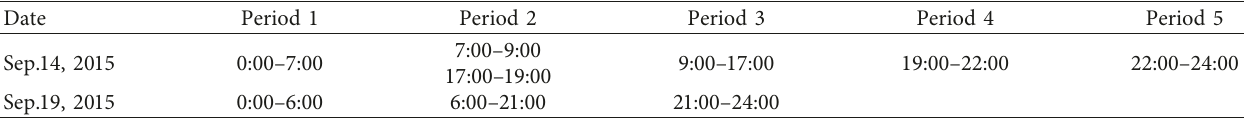
Table 3: Path statistics time